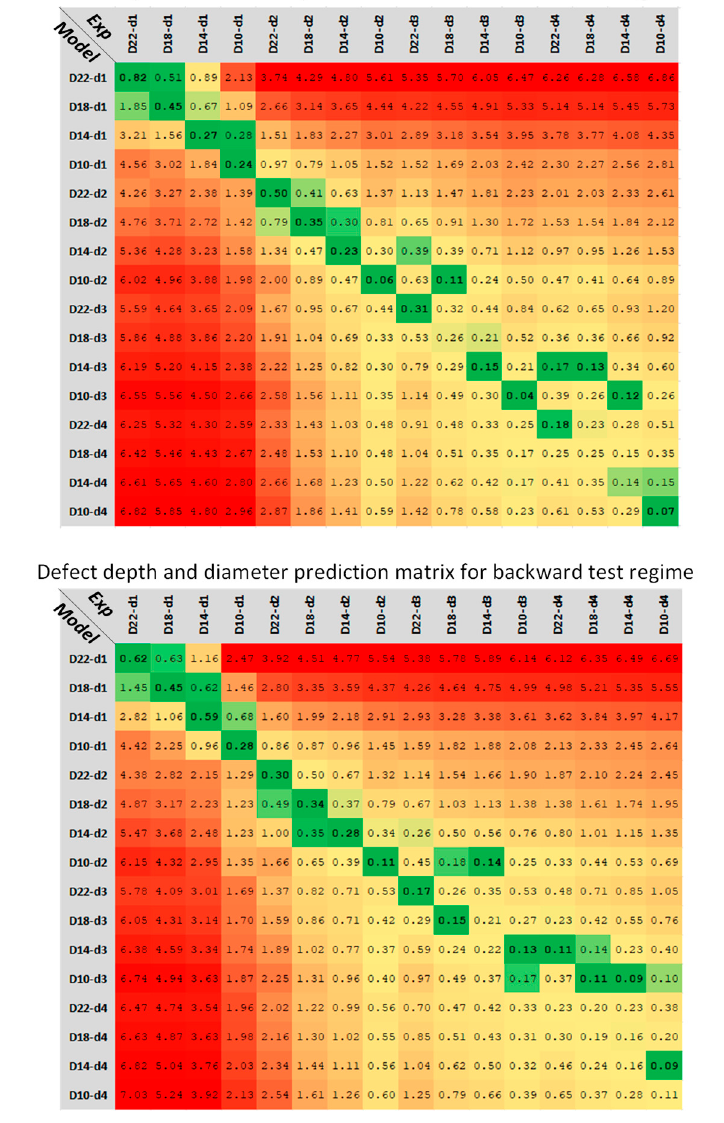
Figure 16. Defect depth and diameter prediction using DTW method for the forward and backward test regimes. Green color reflects the 10% percentile minimum range of similarity scores and change of colours towards red is equivalent to reduction of similarities (increasing similarity score) between experimental contrast and analytical model contrast time-series.